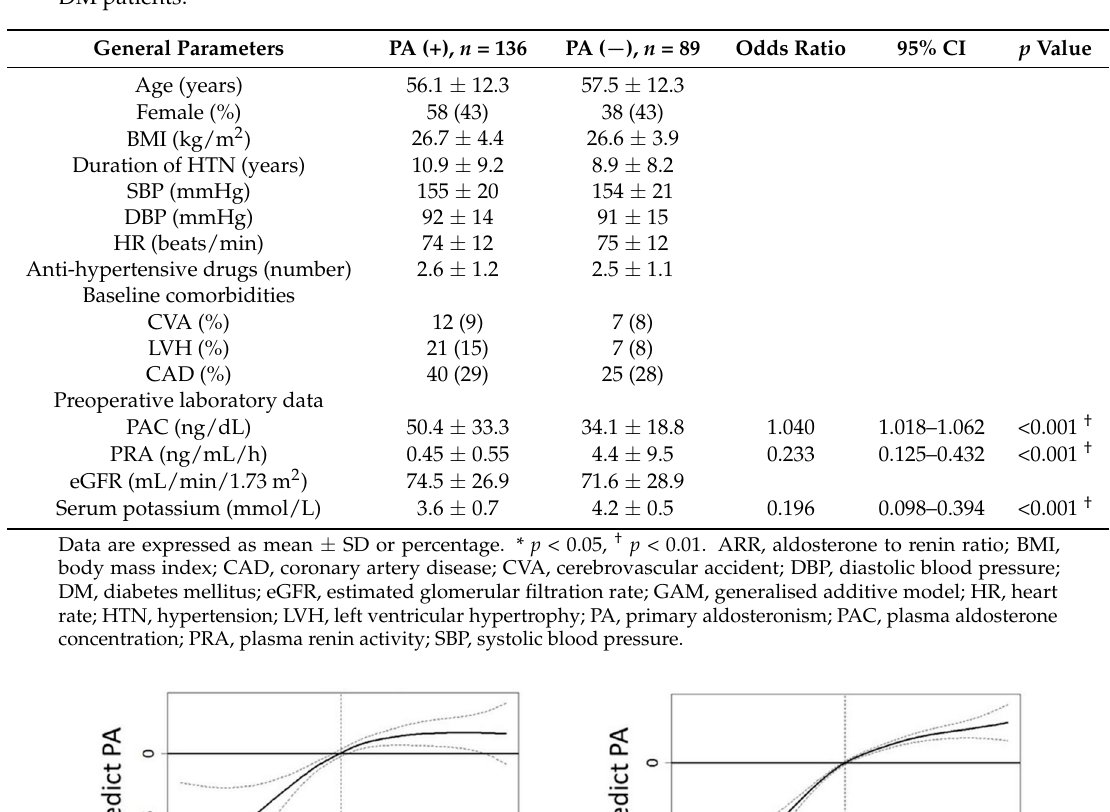
Table 3. Results of multivariable logistic regression generated for predicting the diagnosis of PA in DM patients.